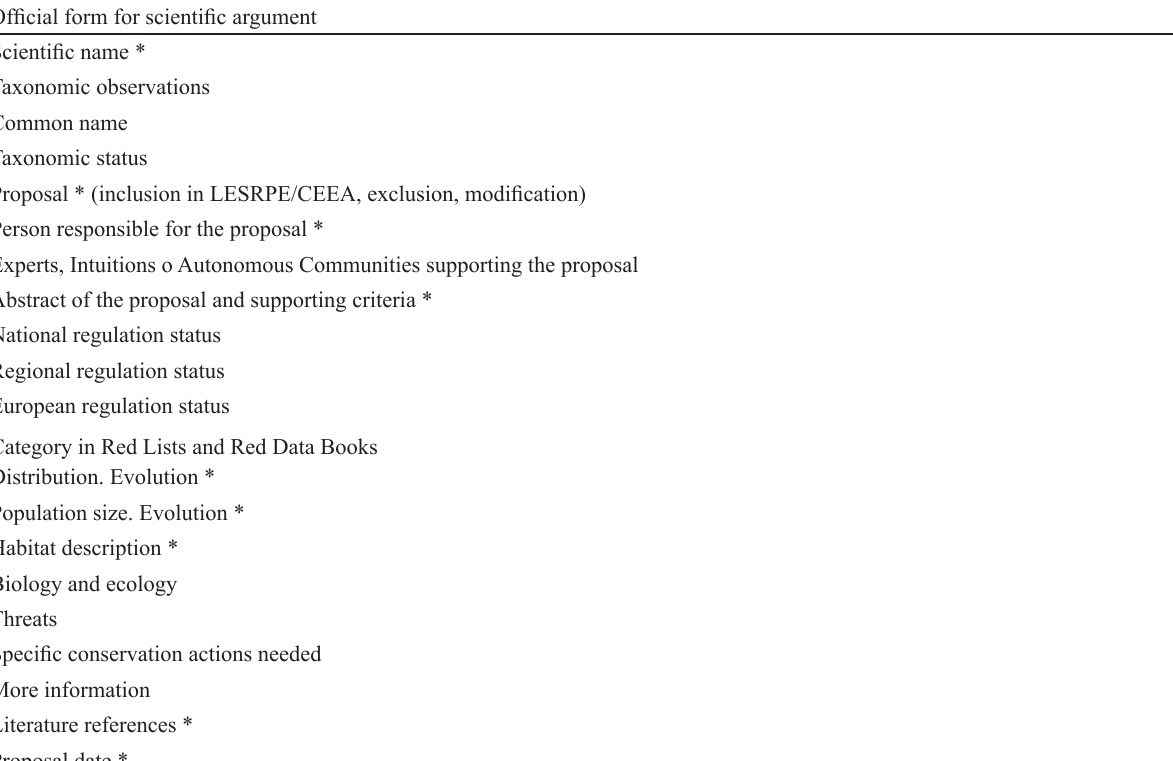
Table 3. Content of the official form for scientific argument established by the MAPAMA for proposals for inclusion, exclusion or change of category of taxa in the Spanish List of Wild Species in Special Protection Regime (LESRPE) and the Spanish Catalogue of Threatened Species (CEEA). Published at Resolution 2977 on March 6 th